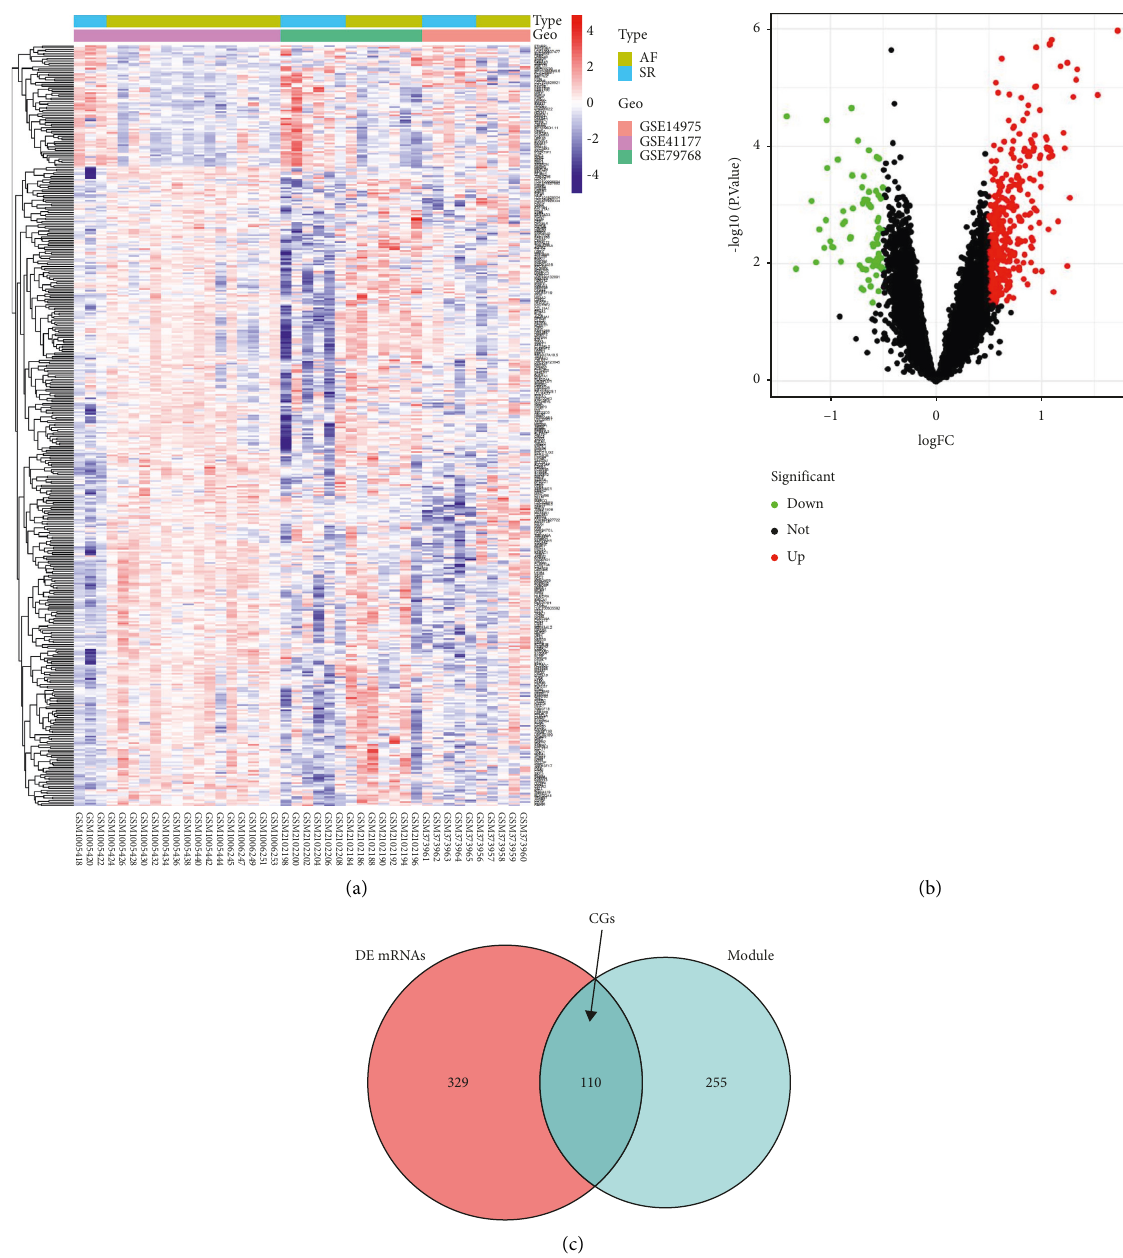
Figure 4: Identification of DE mRNAs in atrial fibrillation from the integrated mRNA data set. Heat map (a) and Volcano plot (b) for the DE mRNAs. (c) A total of 110 overlapping genes defined as common genes (CGs) between the DE mRNAs and the genes found in the most significant module were